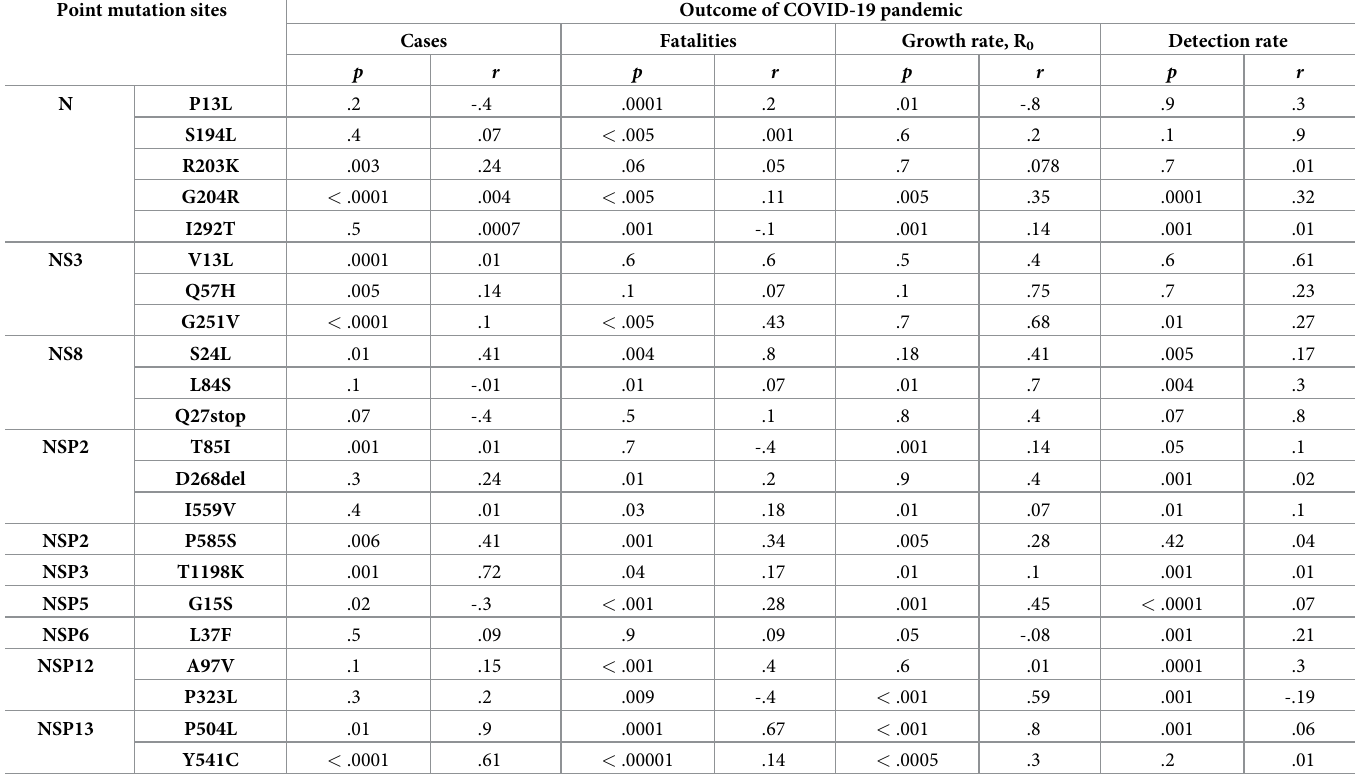
Table 3. Pearson correlation coefficient between specific mutations of SARS-CoV-2 proteins and COVID-19 cases, fatalities, transmission rate (R 0 ), specific muta- tions and detection rate. Point mutation